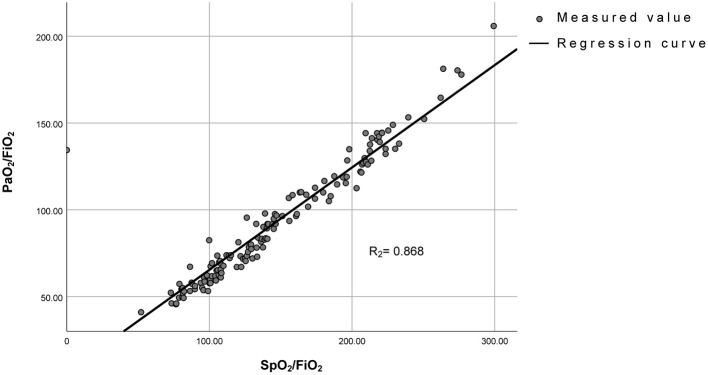
Linear correlation between PaO2/FiO2 and SpO2/FiO2. PaO2/FiO2= 0.59* SpO2/FiO2 + 6.458 (R2 = 0.868).